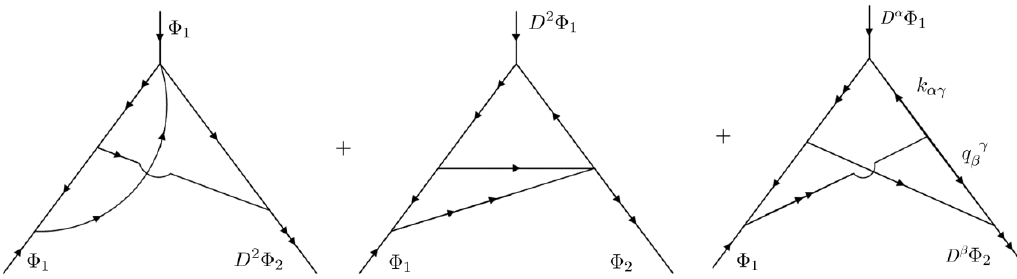
Figure 21. Diagrams resulting from the D-algebra reduction of diagram